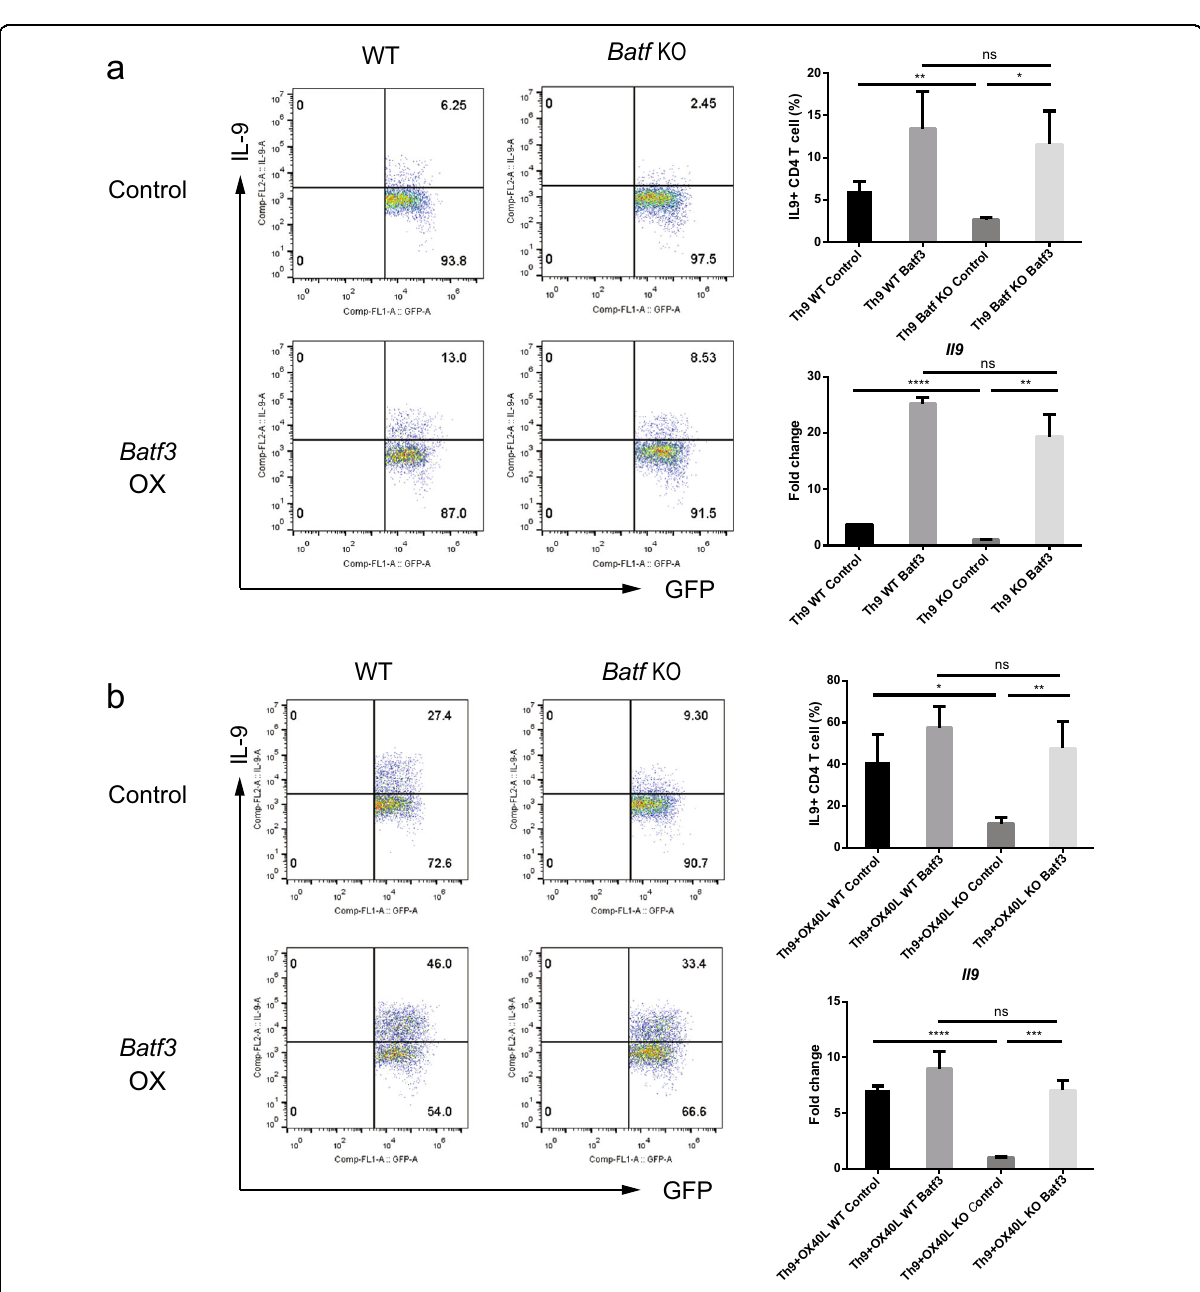
Fig. 5 BATF3 can compensate for the loss of BATF and induce Il9 expression. a , b Batf KO naive CD4 + T cells were transduced with a retroviral construct and cultured under Th9 ( a ) or Th9 + OX40L ( b ) conditions. Transduced cells were gated for GFP, and IL-9 production was measured by fl ow cytometry. In addition, transduced cells were sorted by fl ow cytometry before RNA isolation. Expression of Il9 mRNA in cells stimulated under Th9 (a) or Th9 + OX40L ( b ) conditions was measured by qRT-PCR. Data were normalized to levels of Gapdh and are shown relative to KO controls under both conditions. OX, overexpression. Error bars represent the s.d. P values were calculated using Student ’ s t -tests. * P < 0.05, ** P < 0.01, and *** P < 0.001. All experiments were repeated independently three